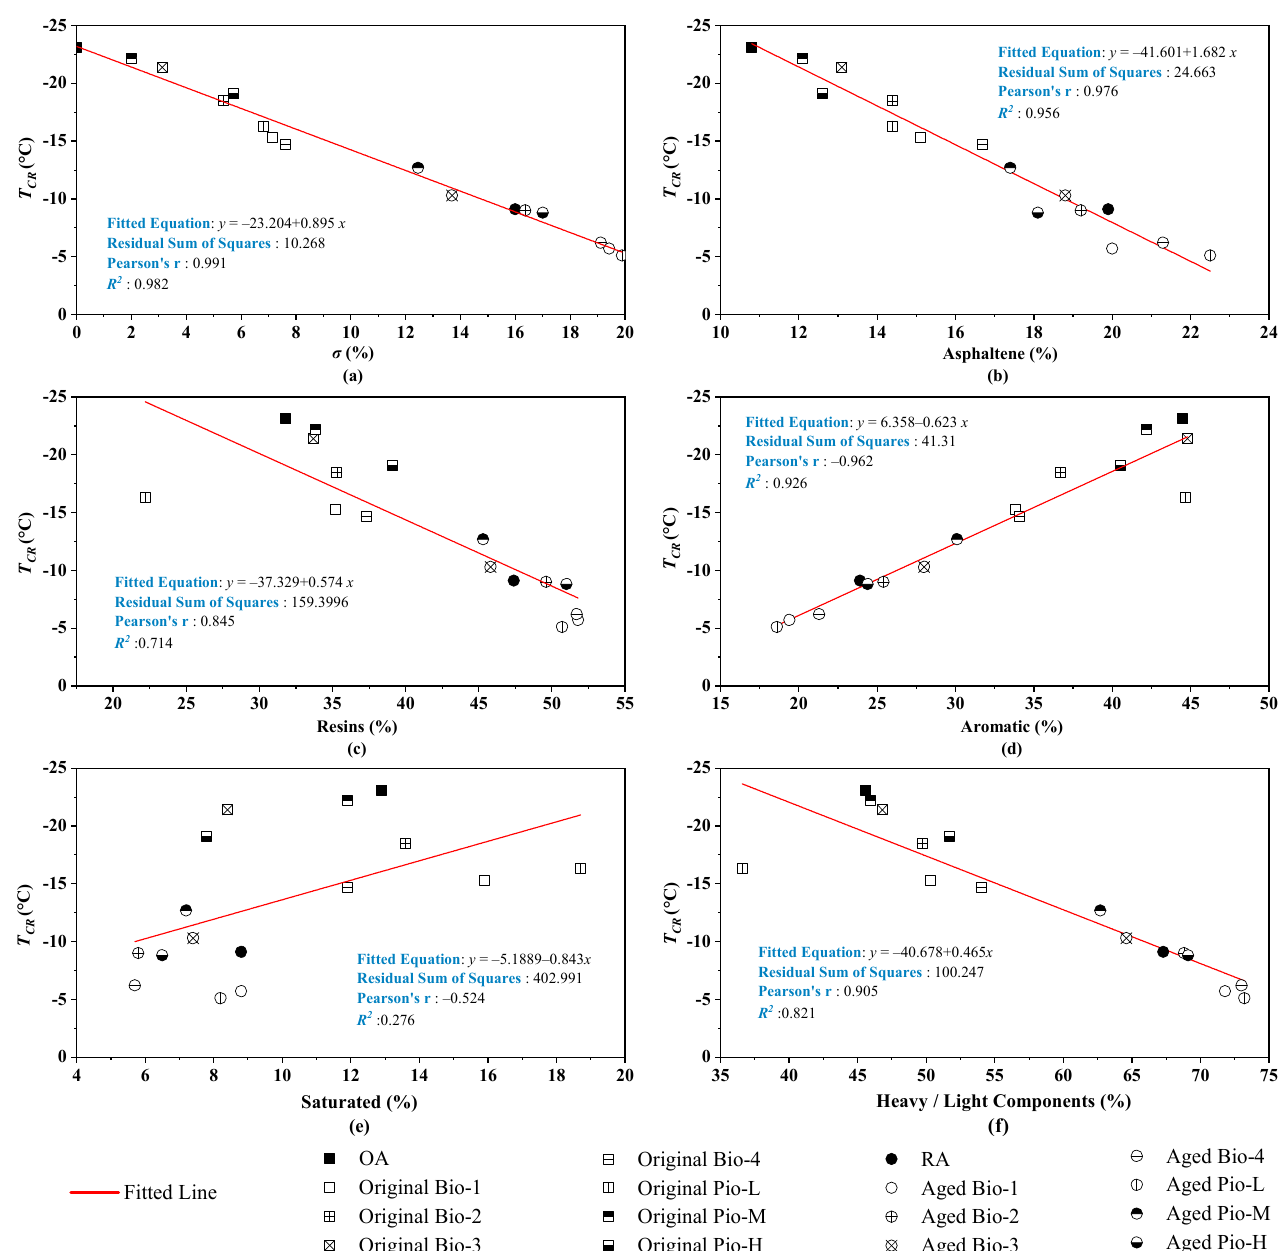
Figure 9. Correlation analysis between the T CR and fraction of ( a ) σ ; ( b ) asphaltene; ( c ) resins; ( d ) aromatic; ( e ) saturated; ( f ) heavy/light.